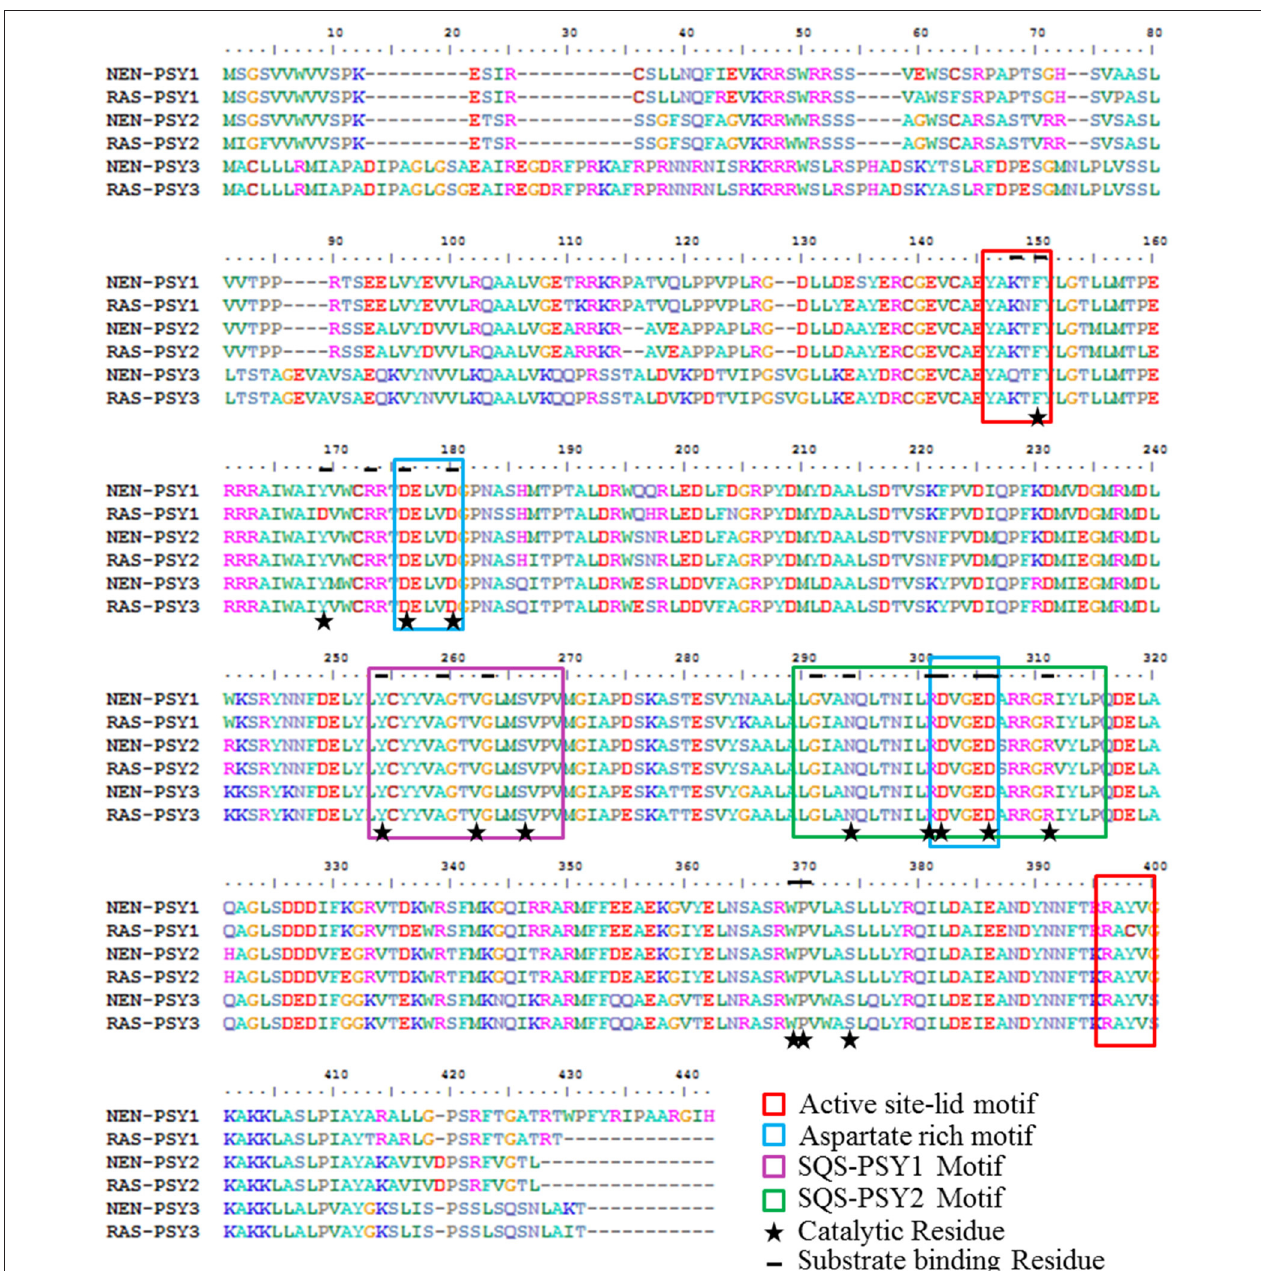
FIGURE 6 | Analysis of banana PSY protein sequences. Multiple sequence alignment of putative protein sequences of PSY from Rasthali (RAS-PSY1 - 3) and Nendran (NEN-PSY1 - 3) cultivars.